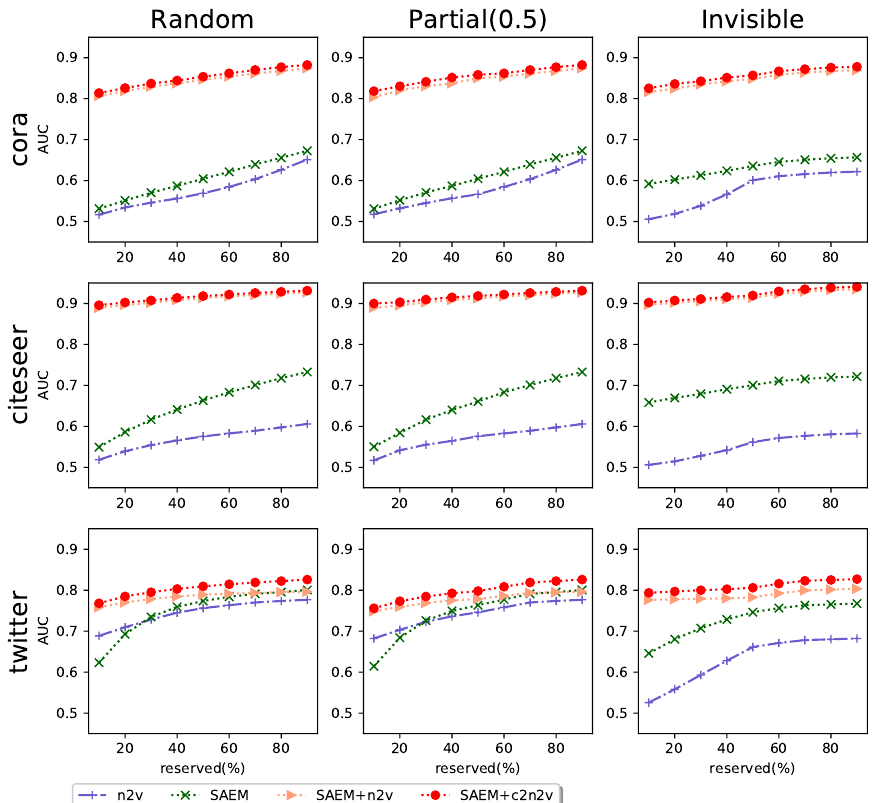
Figure 3. Results of Area Under Curve (AUC) scores on link prediction for three privacy settings and three